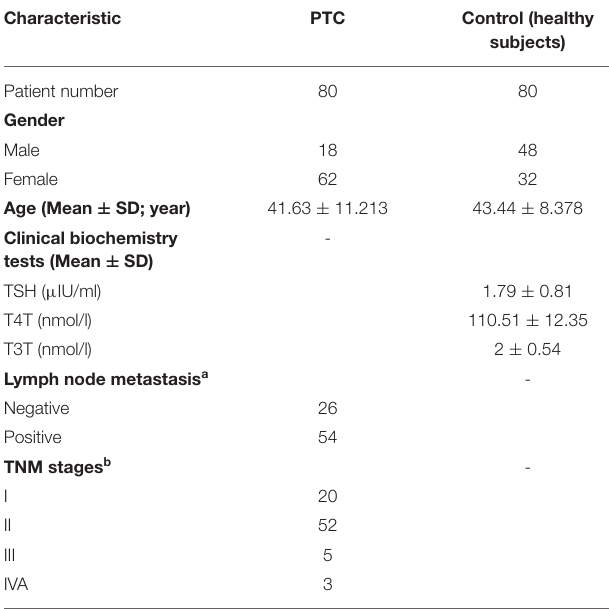
TABLE 1 | Clinical and pathological characteristic of the